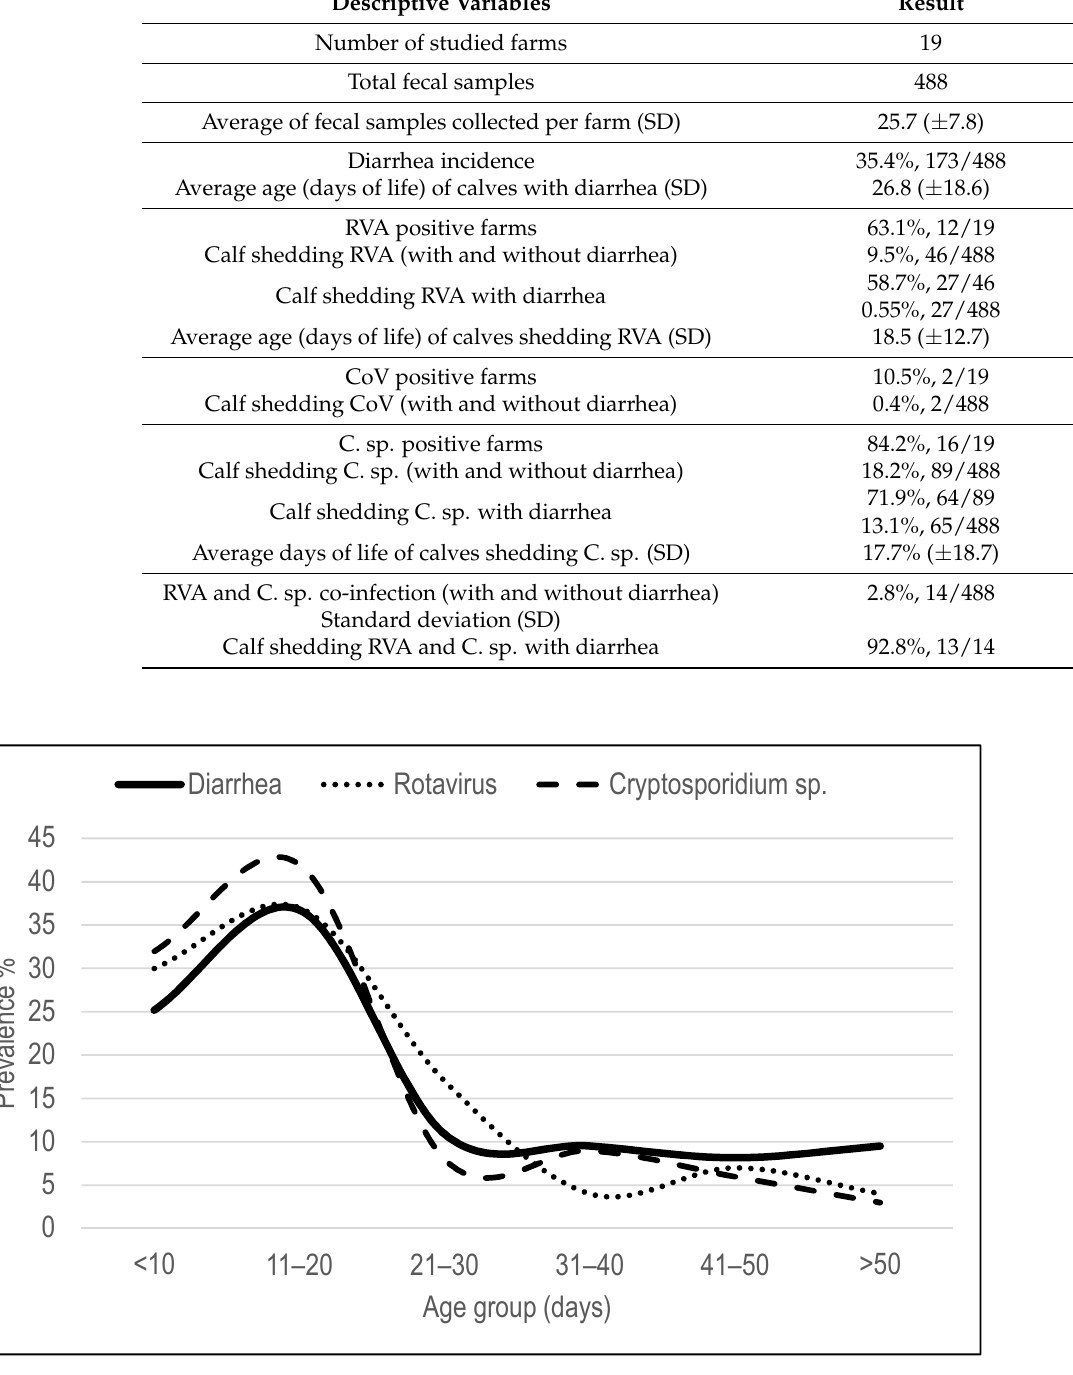
Table 1. Descriptive result analysis of the variables included as influential factors from the survey performed between 2014 and 2016.